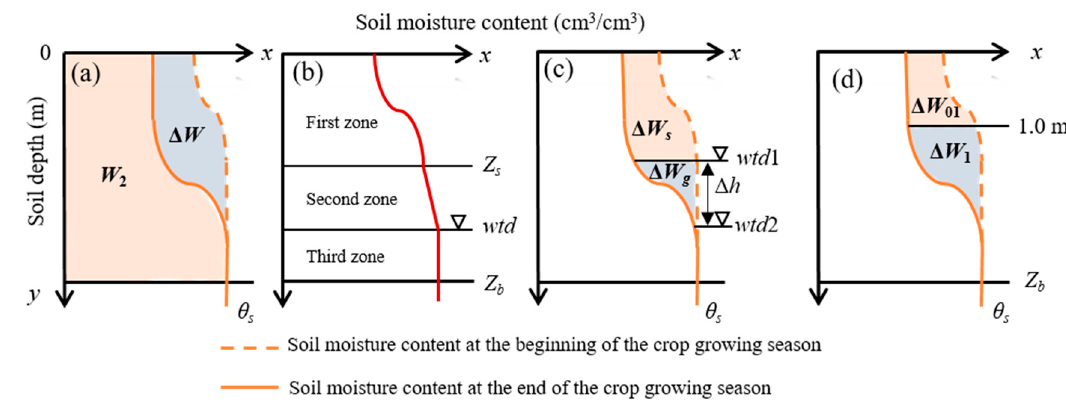
Figure 3. The schematic diagrams of ( a ) the soil moisture profiles at the beginning and end of the crop growing season, ( b ) the three zones of the vertical soil profile for calculating the water storage (marked as W ), ( c ) the soil water storage utilization (marked as ∆ W s ) and the ground water utilization (marked as ∆ W g ) and ( d ) the soil-ground water storage utilization below 1 m soil depth (marked as ∆ W 1 ) and above 1 m soil depth (marked as ∆ W 01 ). Note: ∆ W is the soil-ground water storage utilization, mm. W 2 is the water storages at end of the crop growing season. wtd is the water table depth, mm. wtd 1 and wtd 2 are the water table depths at the beginning and end of the crop growing season, mm. ∆ h is the variation of water table depth during the crop growing season, mm. Z s is the maximum sampling depth, mm. Z b is the maximum computational depth, mm.